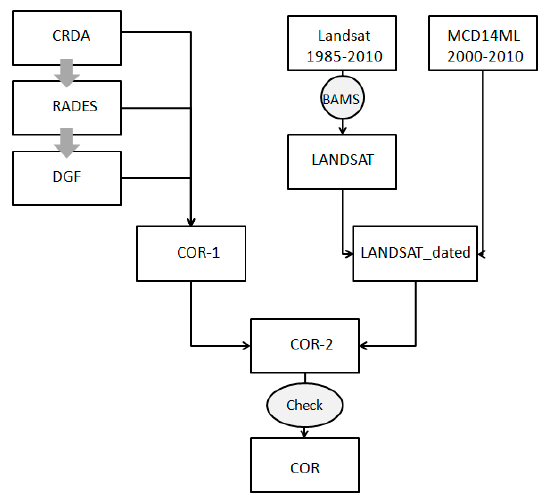
Figure 2. Flow chart of the data processing chain. CRDA (Commissariat Régional au Développement Agricole), RADES (Rades forest service centre), and DGF (Direction Générale des Forêts) refer to the local data source. COR-1 refers to the first correction phase assembling all available databases. LANDSAT are the fire events for which burned area was derived from the BAMS (Burned Area Mapping Software) [48] fire hotspots to derive LANDSAT_dated data. COR-2, merging COR-1 and LANDSAT_dated, was